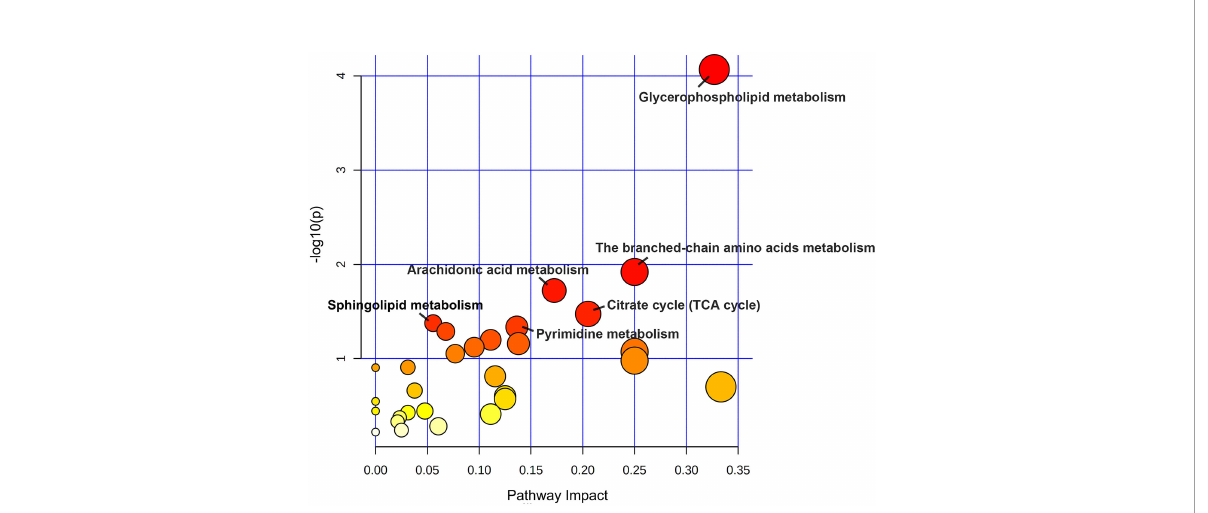
FIGURE 5 The KEGG metabolic pathway impact analysis. The color and size of each node are based on the p values and pathway impact values, respectively. The “ human Homo sapiens (KEGG) ” library was selected to perform pathway enrichment analysis and topology analysis. The X-axis presents pathway impact values (based on Out-degree Centrality) and the Y-axis presents the respective p values (based on hypergeometric test). Each circle represents a pathway. The size of circle indicated the pathway impact score, whereas the color represents the p values. Larger circles represent higher impact factors, redder colors represent lower p values. Pathways with p values less than 0.05 were marked by